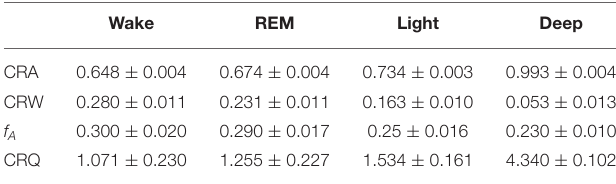
TABLE 4 | Cardiopulmonary Resonance Indices of one subject in different sleep stages of a whole night.